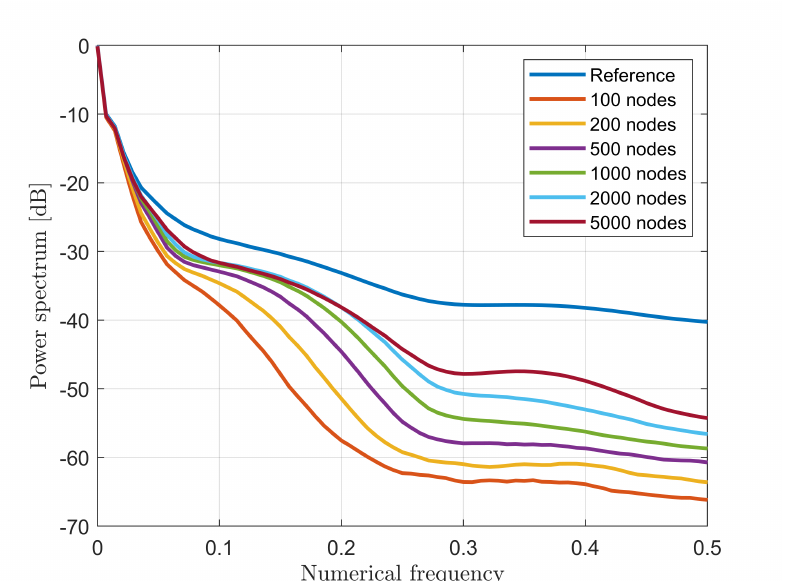
Figure 4. Averaged spectrum S ( ν ) for six different three-layer architectures as a function of nodes number per each hidden layer.